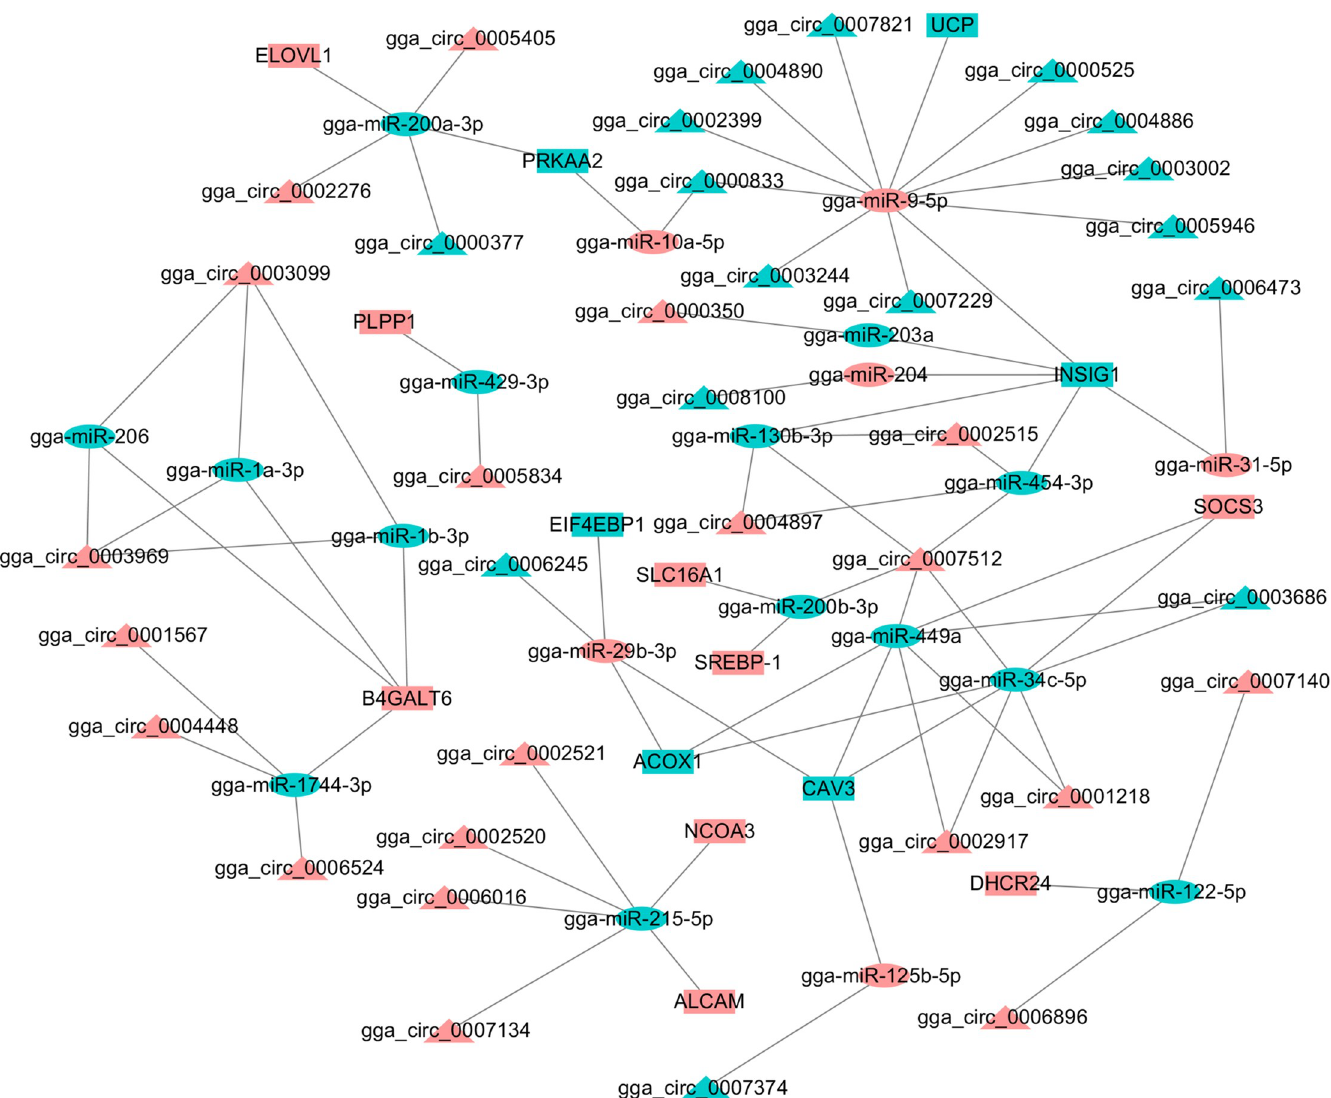
Fig 8. CircRNA-miRNA-gene interaction network contained thirteen lipid metabolism- or deposition-related pathways. The ellipse, triangle and box nodes represent miRNAs, circRNAs, mRNAs, respectively. Pink indicates upregulation, and blue indicates downregulation.